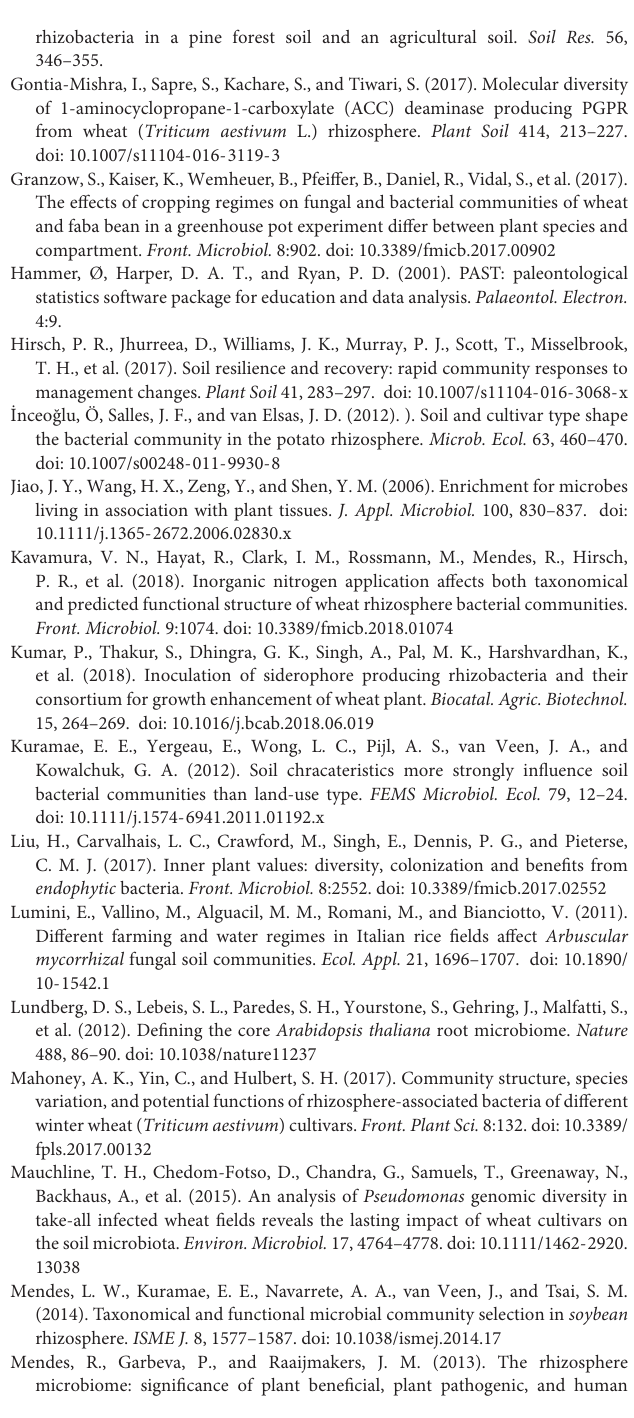
[continuous arable (AA), conversion of bare fallow to arable (BA), and conversion of grassland to arable (GA)]. The color scheme varies from light gray to black, with light gray color indicating OTUs which were found to be less abundant, and dark gray and black indicating which OTUs were enriched, with black being more abundant than those indicated by the dark gray